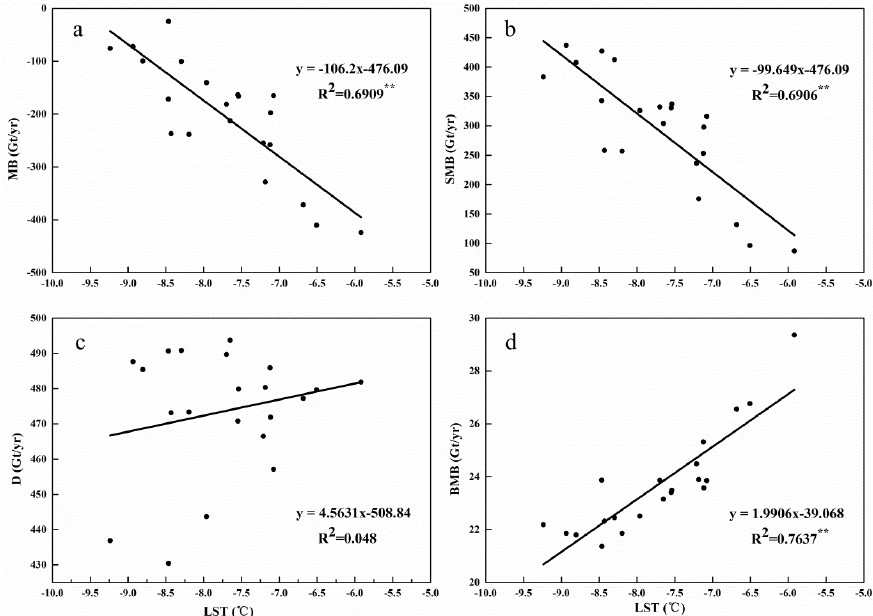
Figure 10. Modelled the GrIS annual ( a ) total mass balance, ( b ) surface mass balance, ( c ) Ice discharge and ( d ) Basal mass balance versus summer LST. All relations are built using 2000 – 2020 data. * and ** Indicates a confidence level of 0.05 and 0.01.